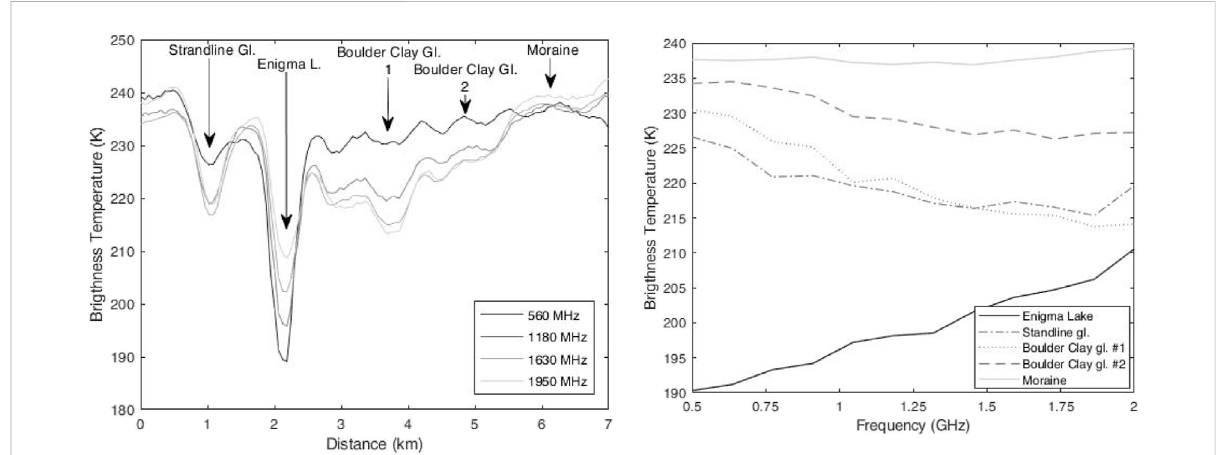
FIGURE 13 (Left) Timeseries of brightness temperature acquired over the Northern Foothills crossing deglaciated terrain and Enigma Lake near Mario Zuchelli Station. (Right) Spectra of the different targets imaged (From Brogioni et al., 2022b).